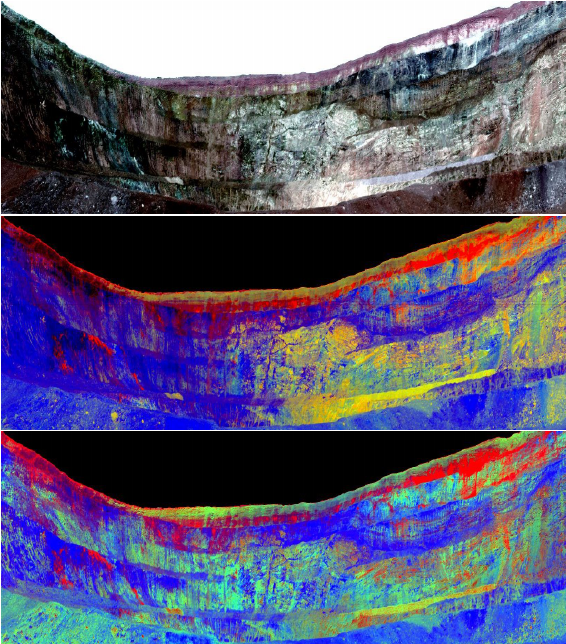
Figure 7. Comparison of three arbitrarily chosen, unfiltered reflectance spectra on single pixels (same pixels in both figures; Figure 6. Inverse SAM image for mine face example 1: R: top: apparent reflectance; bottom: DROACOR-H Kaolinite, G: Hematite, B: Goethite. Top: based on radiance image, Middle: based on apparent reflectance, Bottom: based on DROACOR outputs